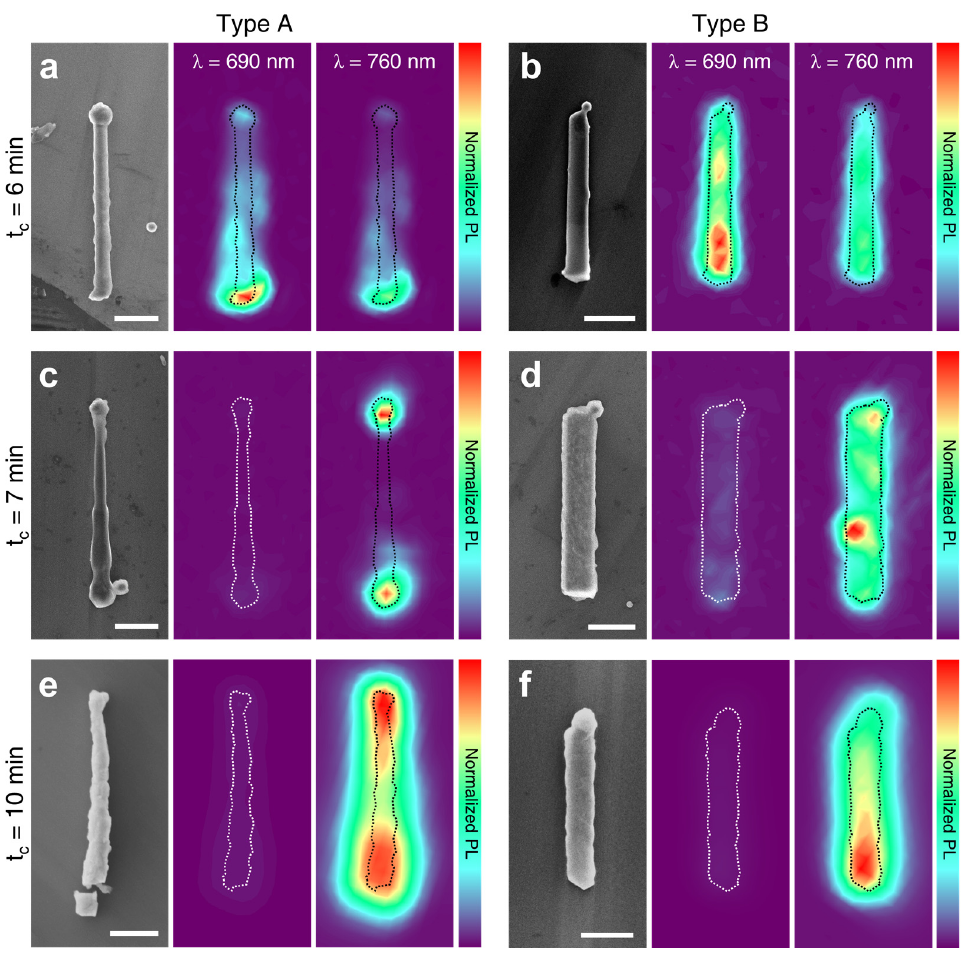
Figure 3. Time-dependent conversion from type A (left) and type B (right) PbI 2 nanowires into CH 3 NH 3 PbI 3 perovskites. Representative SEM images coupled with the photoluminescence (PL) intensity mappings at λ = 690 and 760 nm obtained from the conversion times of ( a , b ) 6 min, ( c , d ) 7 min, and ( e , f ) 10 min introducing vapor-phase CH 3 NH 3 I (MAI). All scale bars, 1 μ